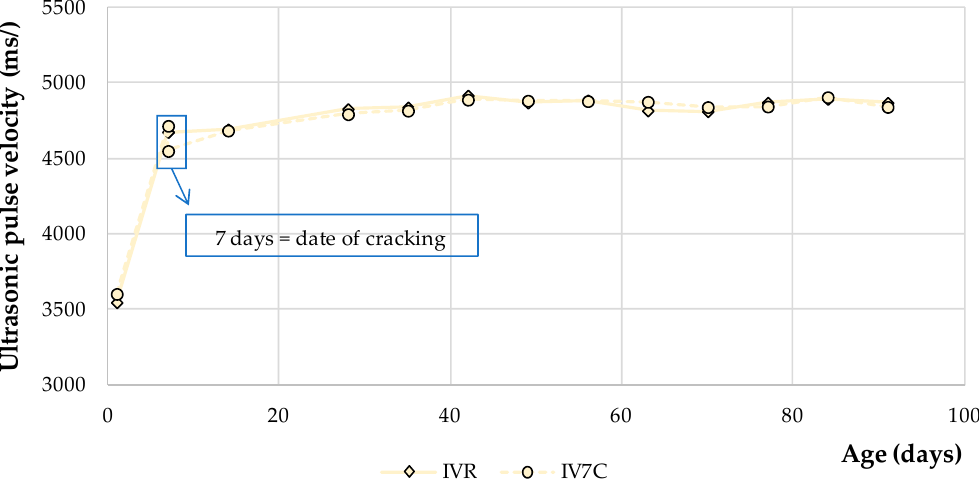
Figure 5. Ultrasonic pulse velocity of uncracked concrete (IVR) and 7 day cracked concrete (IV7C) with CEM IV/A.